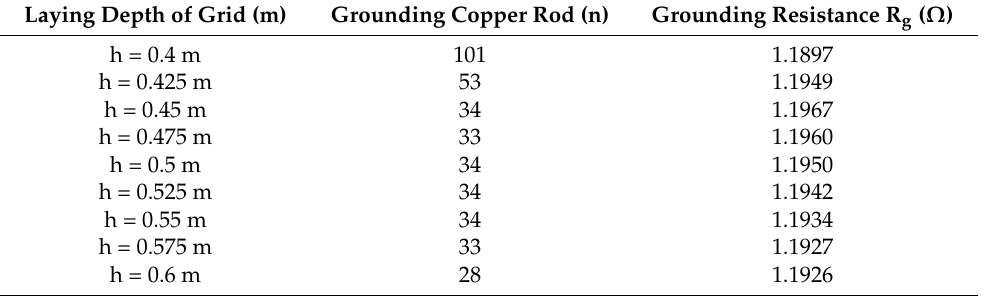
Table 2. Simulation results of the adaptation function for IEEE Std. 80-2000 by MOPSO at grounding grid depths of h = 0.4–0.6